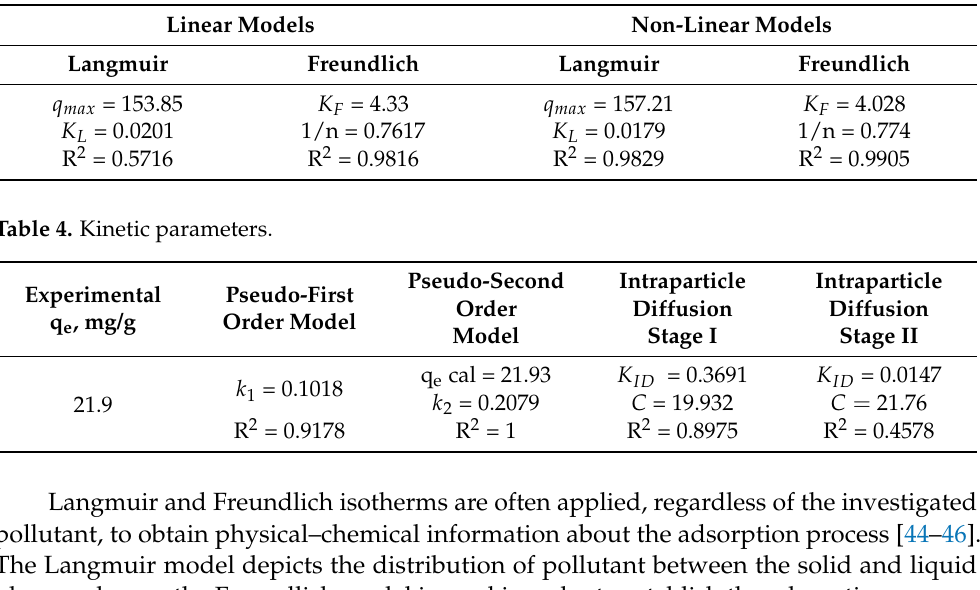
Table 3. Adsorption isotherm constants.